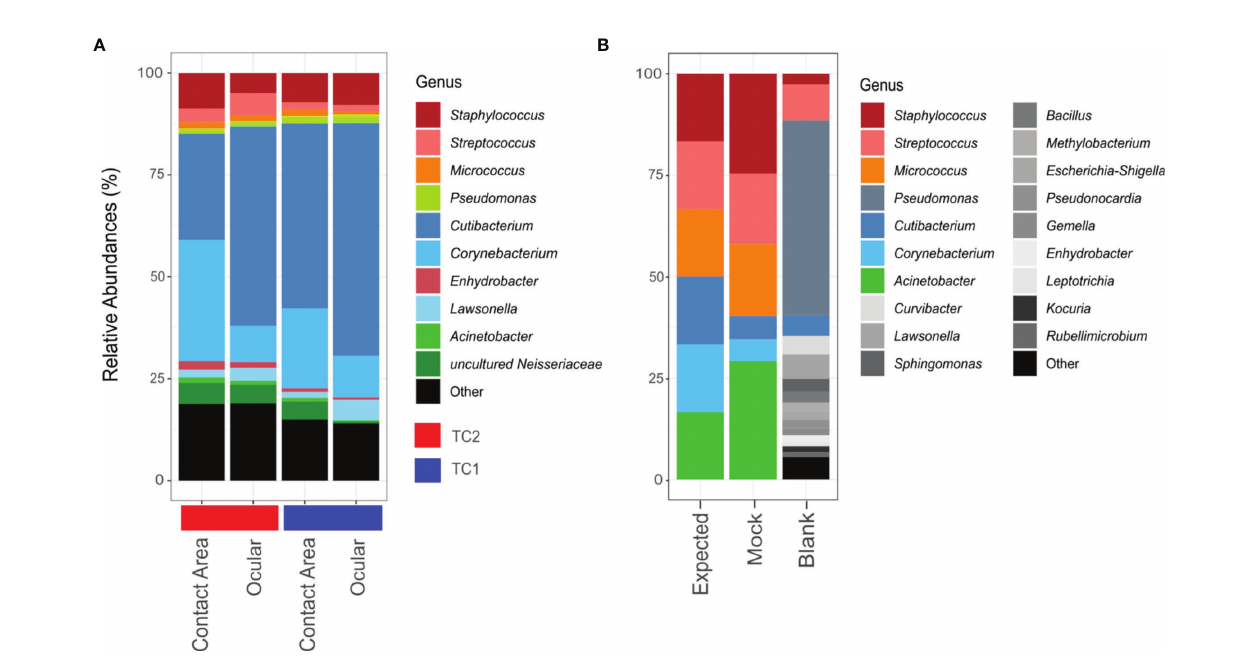
FIGURE 2 | Bar chart of relative abundances of ASVs classi fi ed on genus level. Taxa with relative abundance of less than 1% were collectively summarized as ‘ Other ’ . (A) Taxonomic composition of the slit lamp bacteriota from TC1 (Tertiary Center) and TC2 respectively and the respective sample sites (contact area – TC1: n = 28; ocular – TC1: n = 28; contact area - TC2: n = 14; ocular – TC2: n = 13). (B) Composition of mock taxa and controls (expected = expected mock abundances; mock = mock standard using Bact-0341f/Bact-0785r primers; blank = blank negative